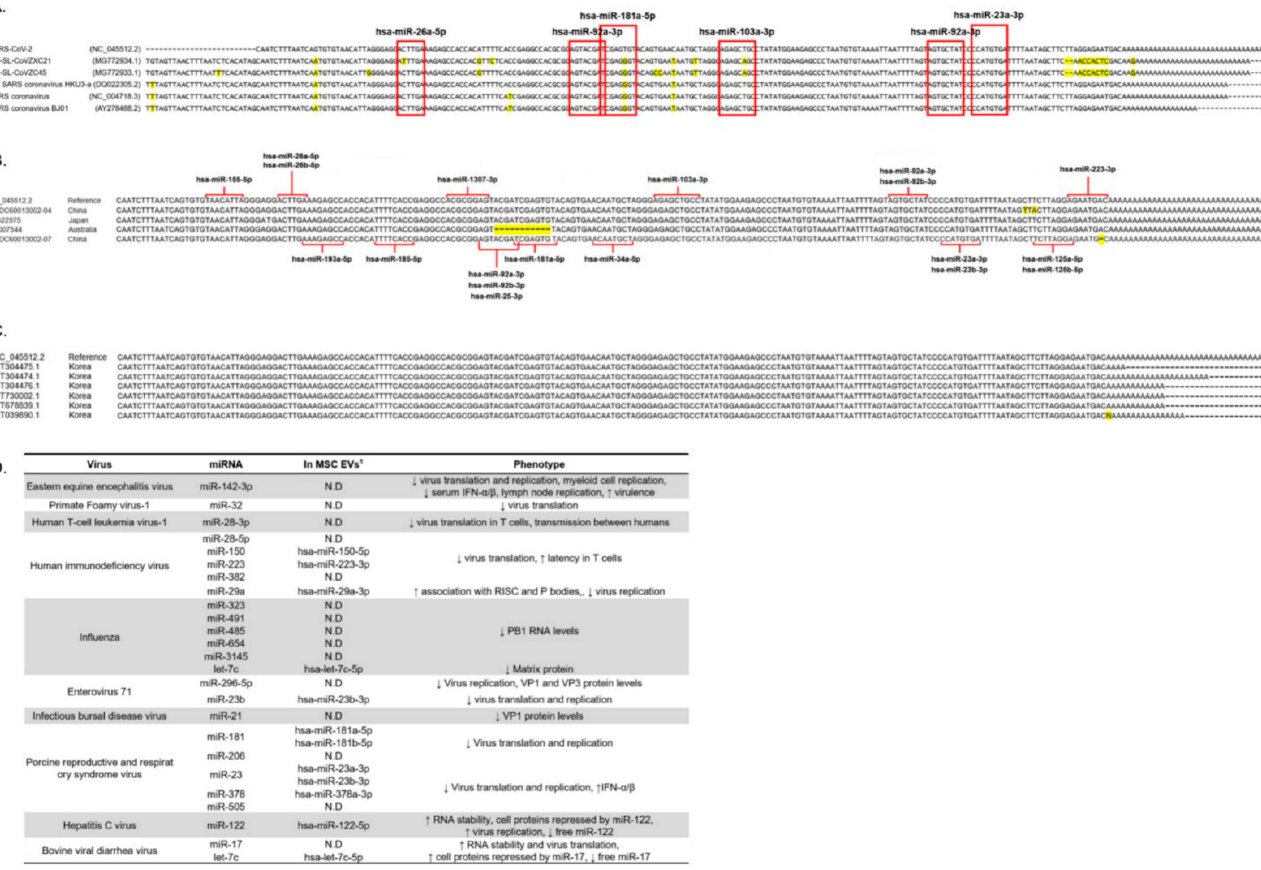
Figure 4. Multi-binding miRNAs will be able to target new mutant SARS-CoV-2 variants. ( A ) 3’ UTR sequence of SARS- CoV-2 of selected five coronaviruses. The red boxes indicate miRNA binding sites to the conserved regions within the 3’ UTRs of five coronaviruses. The label on the left panel shows virus names and GenBank accession. Mutated nucleotides are indicated in yellow. ( B ) Each 3’ UTR sequence was aligned to 3’ UTR sequence of NC_045512.2 using the MUSCLE tool. The label on the left panel shows GenBank accession and location where the virus was found. Red lines indicate interaction between 3’ UTR sequence and miRNA. Mutated nucleotides are indicated in yellow. ( C ) 3’ UTR sequence of 6 complete genomes obtained from SARS-CoV-2 isolated from Korean patients was aligned. Six complete genomes of SARS- CoV-2 isolated from Korean patients were submitted to GenBank from February until July 2020. Mutated nucleotides are indicated in yellow. ( D ) Modified table obtained from published reports [3]. The table shows the known interaction between miRNA and viral RNA and that there are several miRNAs existing in pMSC-EVs (1. The detected miRNAs in pMSC-EVs). “ ↑ ” means up-regulation. “ ↓ ” means down-regulation. “N.D.” means not